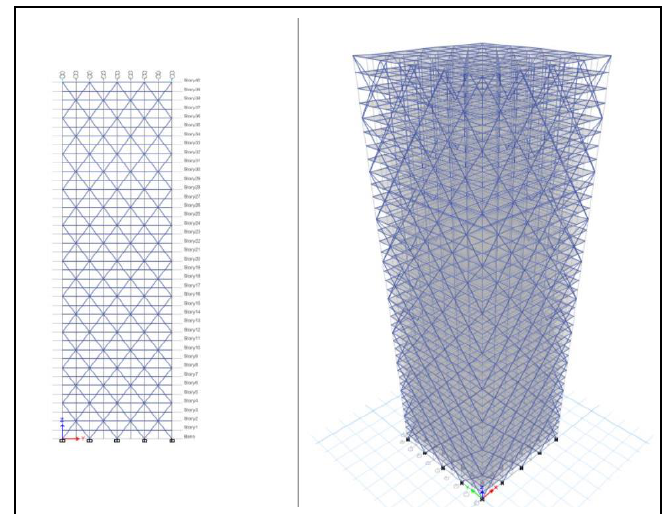
Fig. 2. Elevation and 3D of four storey